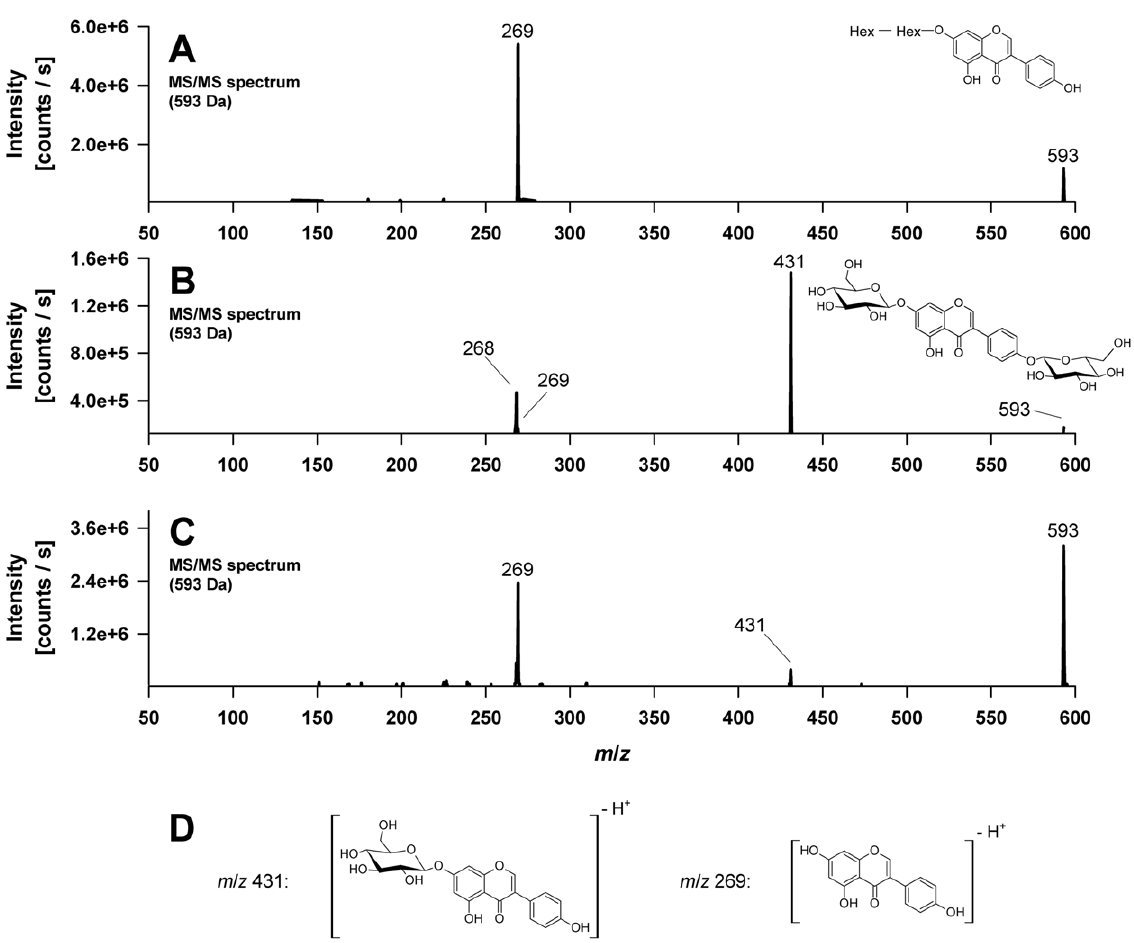
Figure 3. Electrospray mass spectrometric detection (QTrap system) of genistein-di- O -hexosides and genistein- O -disaccharides formed by C.elegans . (A) MS/MS spectrum of metabolite M7, assigned to a genistein-disaccharide with a proposed chemical structure. (B) MS/MS spectrum of metabolite M1, identified as genistein-4 9 ,7-di- O -ß-D-glucoside using a standard compound. (C) MS/MS spectrum of metabolite M3, characterized as a genistein-di- O -hexoside. (D) Proposed structures of the product ions observed in the MS/MS spectra shown under (A), (B) and (C). Hex, Hexose.